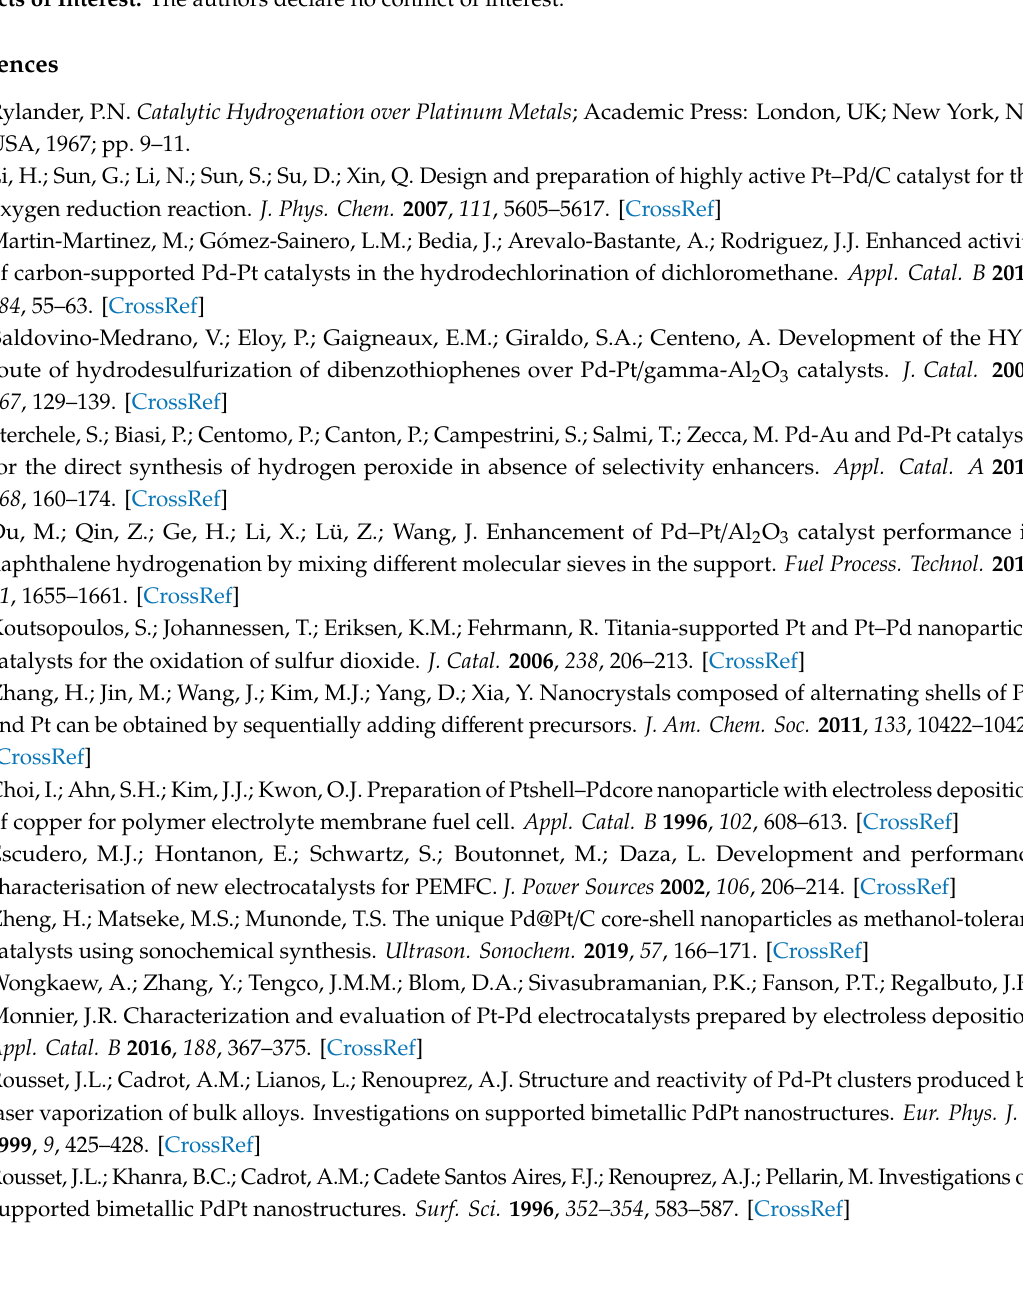
of Pd-Pt / Norit1600 catalysts: Figure S11: Survey spectra of Pd-Pt / Norit1600 catalysts, Figure S12: C1s peak; SET S5. Catalytic data: Figure S13: Hydrodechlorination of CHClF 2 at 270 ◦ C. Time-on-stream behavior of Pt 100 (Cl) and Pd 100 (acac) catalysts, Figure S14: Steady state conversion as a function of the Pd-Pt alloy composition at two reaction temperatures: 251 and 272 ◦ C. A – for ex-methyl acetylacetonates, B- for ex-metal chlorides. GHSV = 5760 h − 1 , Figure S15: Catalytic activity of Pd-Pt / Norit1600 catalysts for CH 2 F 2 (left side) and CH 4 (right side) formation at di ff erent reaction temperatures. GHSV = 5760 h − 1 , Table S2: Compilation of published data on catalytic activity of palladium in the hydrodechlorination of chlorodifluoromethane